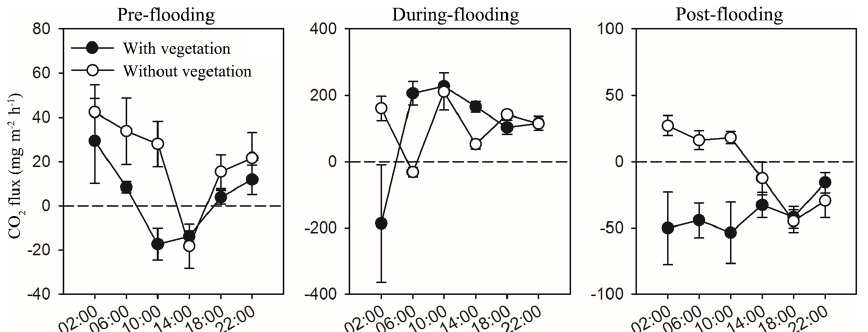
Figure A2. Effects of time (measuring times in 1d) on CO 2 flux in the water–air surface of the fluvial area with vegetation (shallow water, filled) and without vegetation (deep water, blank) in the three sampling stages. Mean ± 1SE is